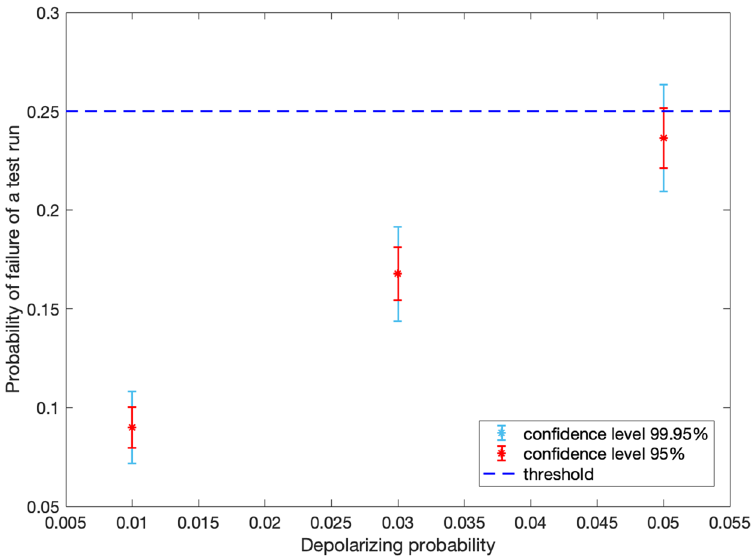
Figure 7. Probability of failure of a test run for different values of depolarizing probability in quantum gates. The blue dashed line represents the threshold 0.25 for w / t